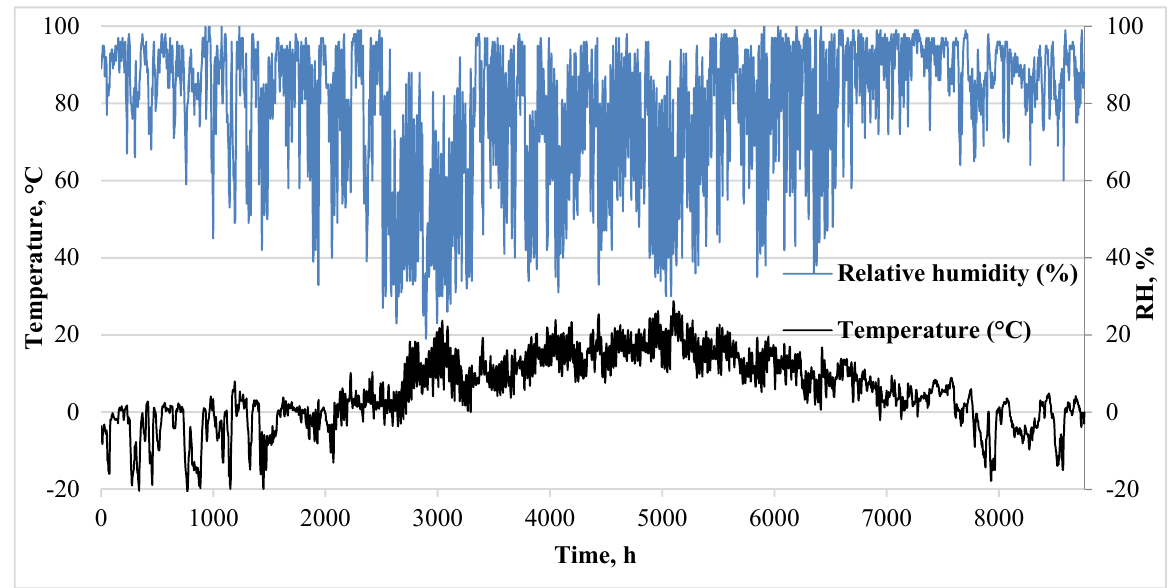
Figure 3. Temperatures and relative humidity for TRY2012 [23].